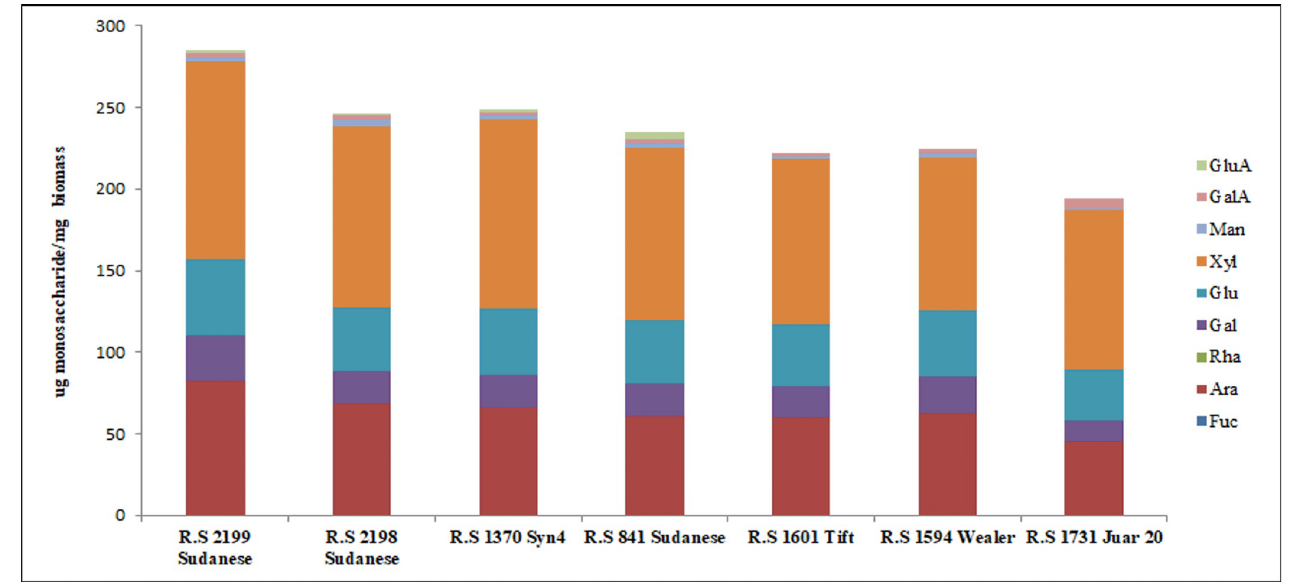
Fig 3. Monosaccharide composition of the matrix polysaccharides in stem cell walls of sudangrass. Monosaccharide composition of the matrix polysaccharides by sudangrass genotype. Note that GalA, Xyl, Gal, and Ara show statistically significant differences across accessions. (S3 Table).